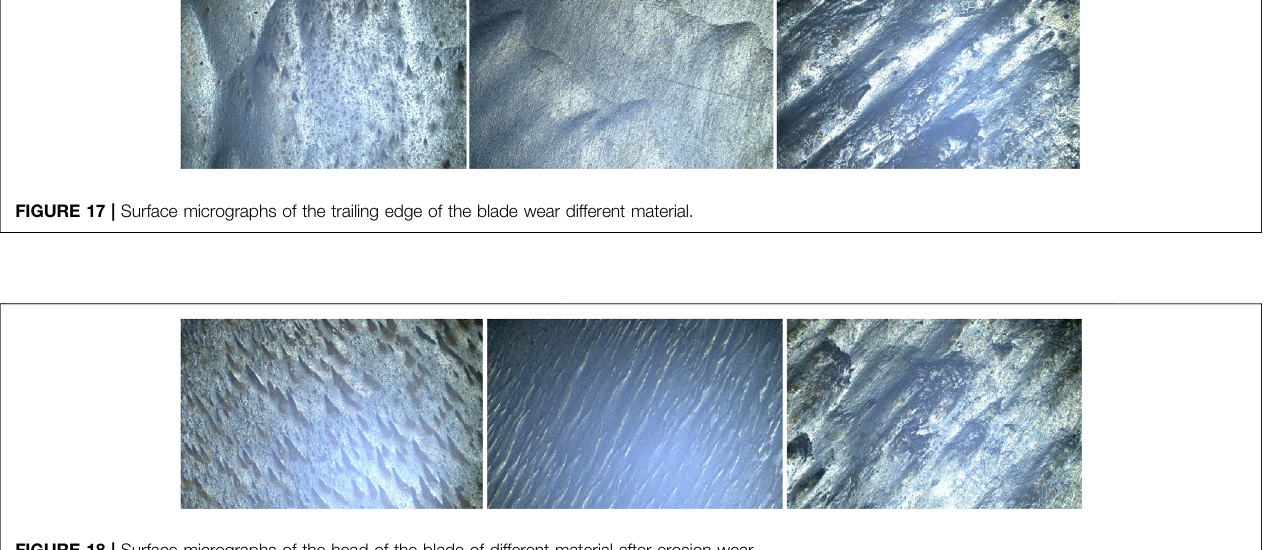
FIGURE 18 | Surface micrographs of the head of the blade of different material after erosion